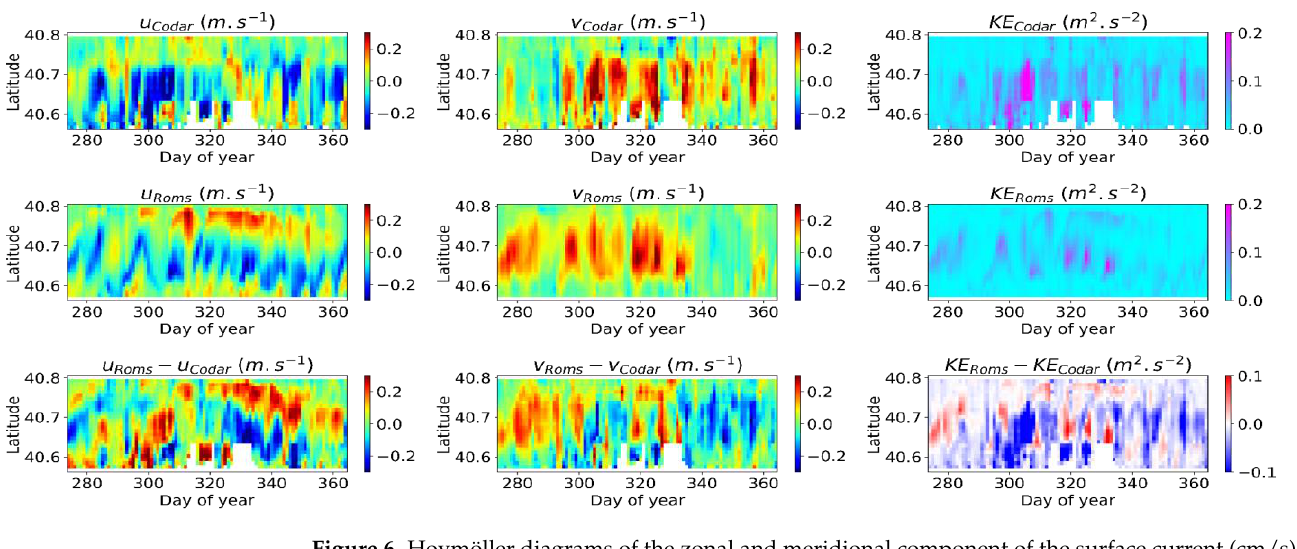
Figure 6. Hovmöller diagrams of the zonal and meridional component of the surface current (cm/s) and kinetic energy measured by the HFR and obtained from model simulation over the transect for the quarter OND in 2010.